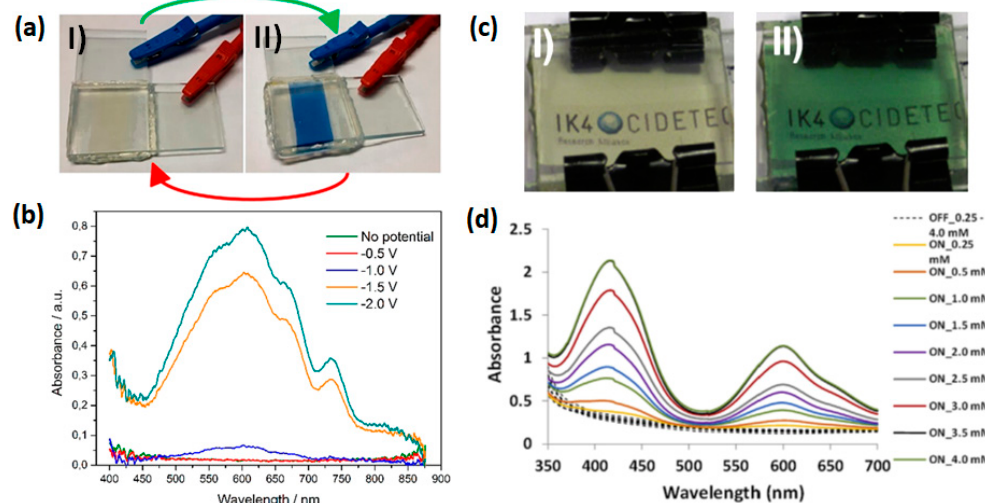
Figure 4. ( a ) The contrast color of ethyl viologen-based ECD at bleached state (I) and colored state (II). ( b ) The UV − vis spectra of ethyl viologen-based ECD at different potentials. ( c ) The contrast color of cyanophenyl viologen based ECD at bleached state (I) and colored state (II). ( d ) The UV − vis spectra of ECDs containing different concentrations of cyanophenyl viologen at their radical states. Reproduced with permission from American Chemical Society [29] and Elsevier Ltd.